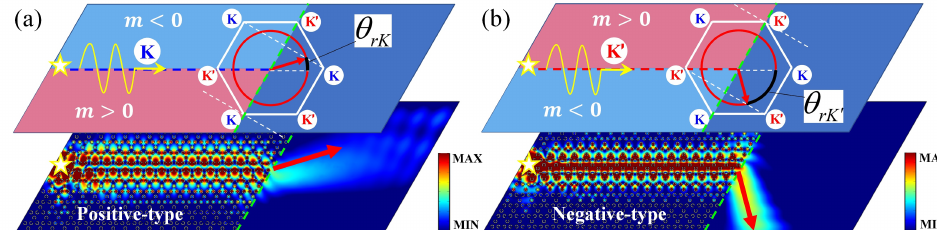
Figure 4. ( a ) The k -space analysis on out-coupling of K valley projected edge states along the positive- type (Zigzag) interface. ( b ) The k -space analysis on the out-coupling of K (cid:48) valley projected edge states along the negative-type (Zigzag) interface. The white solid hexagon represents the first Brillouin zone, and the red solid circles show the dispersion in background material Si. The simulated distribution of fields at the frequency f = 0.102 THz (in bandgap) are separately illustrated in the bottom panels. The light-red and light-blue regions represent m > 0 and m < 0,